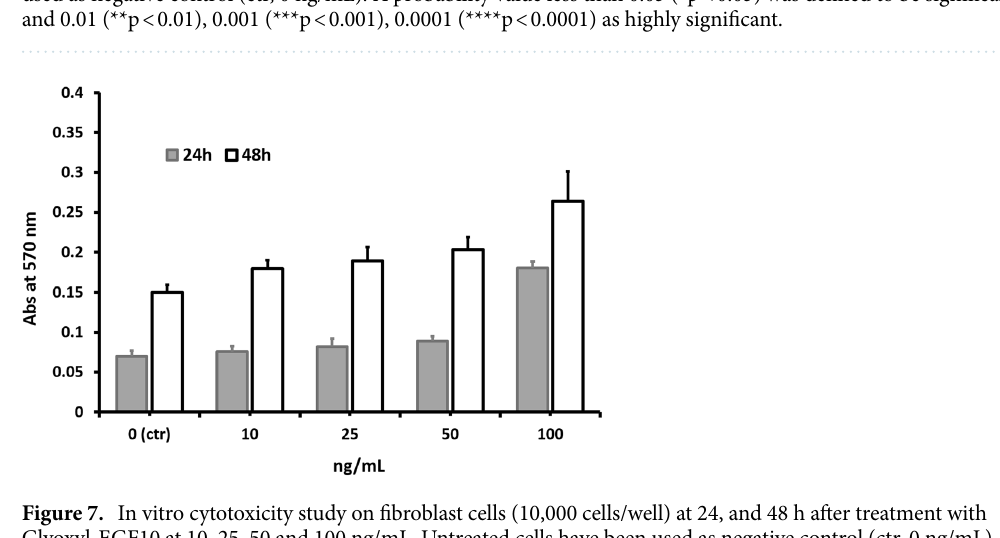
(p < 0.05) in absorbance at 100 ng/mL concentration from free EGF to CNBr-EGF. No significant difference was revealed between CNBr-EGF and Glyoxyl-EGF7 immobilized samples. These two EGF derivatives showed an overall increase in cell viability when compared to the control (CNBr-activated-agarose and glyoxyl-agarose carriers) this finding. The growth observed on the carrier without the immobilized proteins (controls) can be ascribed could be due to agarose acting as a nutrient and/or a scaffold for the cells to grow. However, when the EGF is immobilized on the carrier, the cell growth clearly increase as consequence of the stimulation mediated by the grow factor . EGF immobilized on glyoxyl-agarose at pH 10 (Glyoxyl-EGF10) was used as control against its one-point immobilization product (Glyoxyl-EGF7), the data showed an increase in the absorbance at 48 h at each concentration. Additionally, the data showed lower values compared with Glyoxyl-EGF7 in particular at 10, 25 and 50 ng/ mL (Fig. 7). The reduction of activity observed with Glyoxyl-EGF10 could be ascribed two-point immobiliza- tion induced when the process is performed at basic pH, that reduce the freedom and the access at the epitopes responsible of the biological activity compared with the protein immobilized only through the N -terminal amino acid.